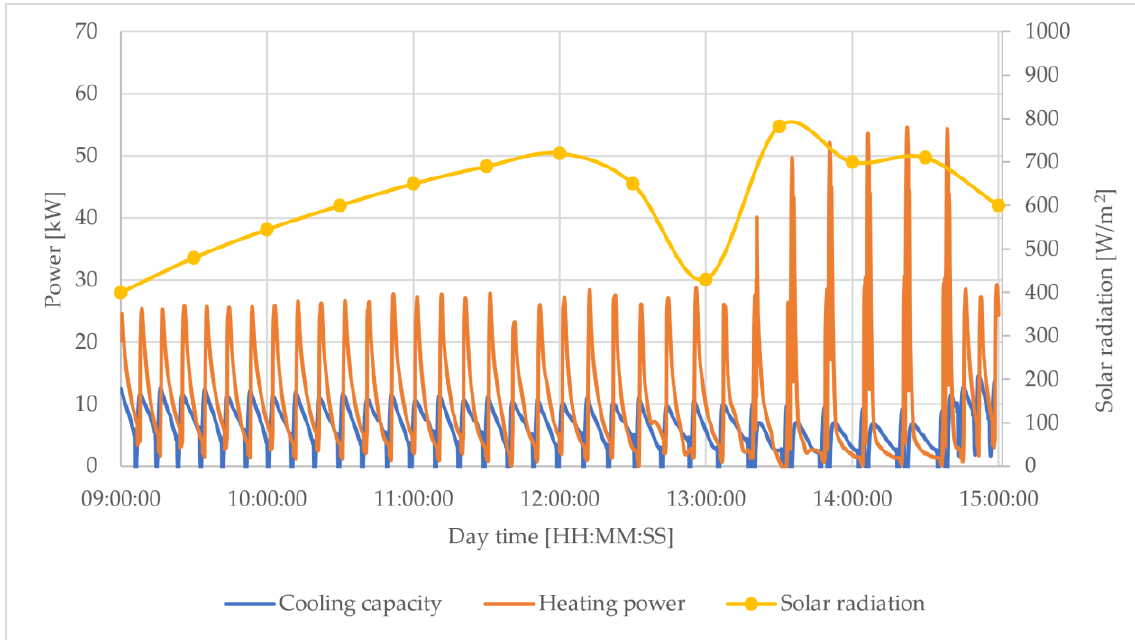
Figure 19. Heating power and cooling capacity values over time for 11th August.